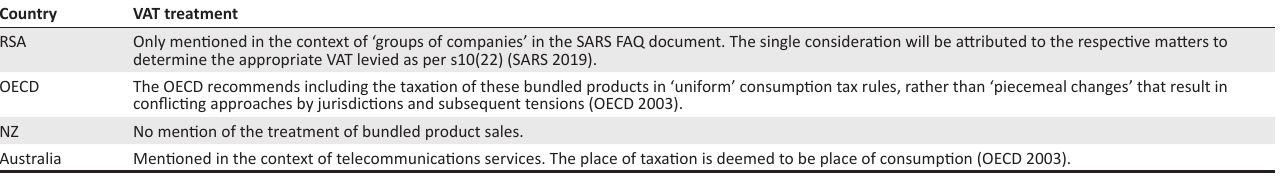
Country VAT treatment